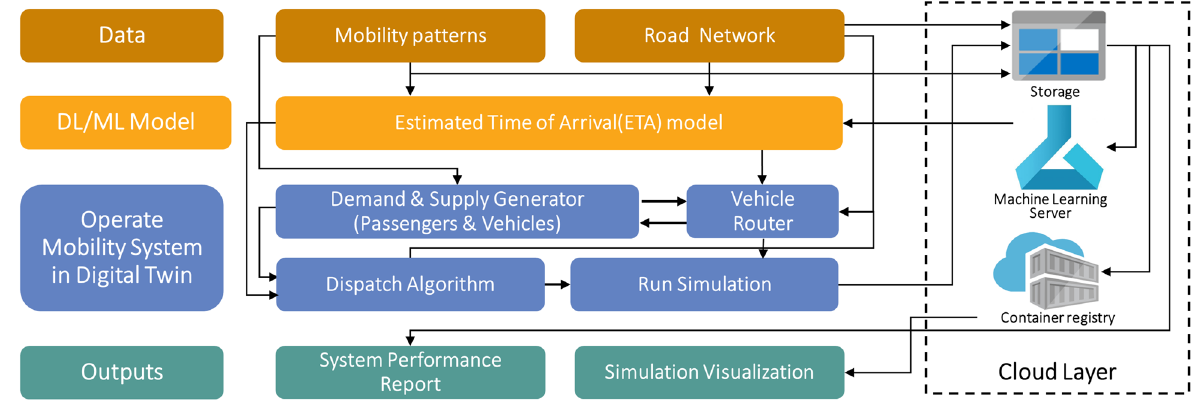
Figure 1. Illustration of the framework of